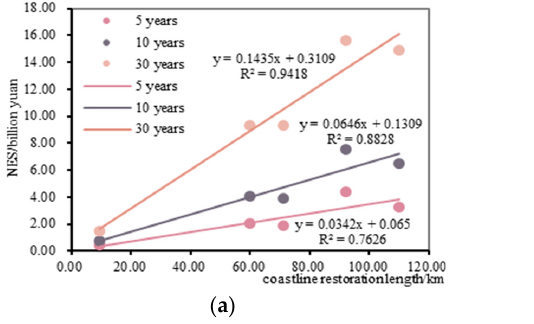
Figure 6. The correlation scatter plot of coastline restoration length and ( a ) NES; ( b ) NES per unit coastline restoration length. coastline restoration